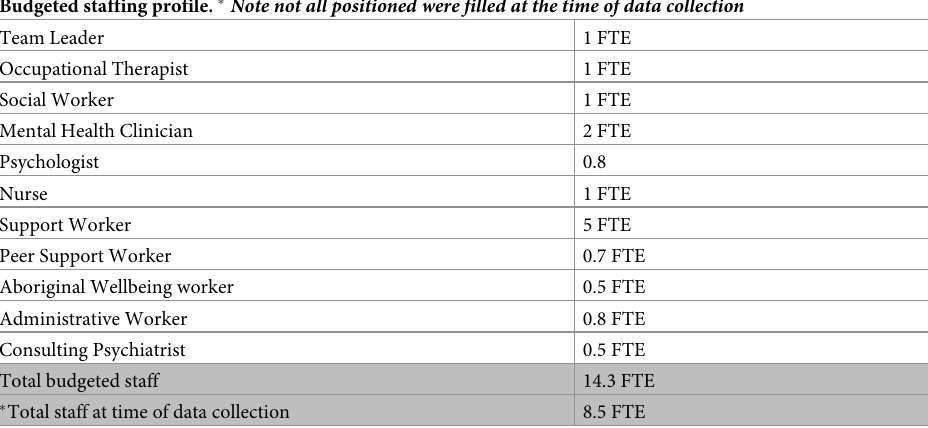
Table 1. Staffing profile of the